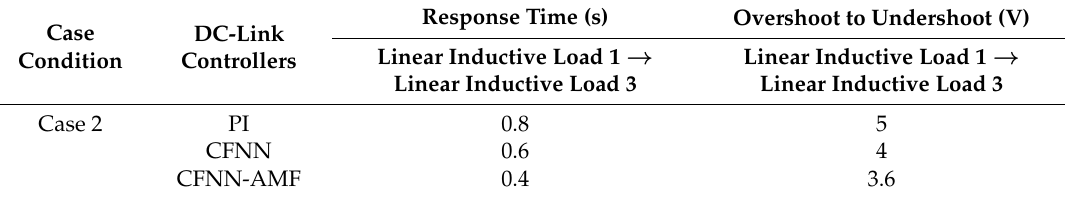
Figure 8. Responses of network parameters of CFNN-AMF controller at case 1: ( a ) Responses of w ( b ) Responses of γ 3 ; ( c ) Responses of m 3 ; ( d ) Responses of σ l 3 ; ( e ) Responses of σ r 3 . Table 4. Response time of DC-link voltage and regulation voltage error for different controllers at case